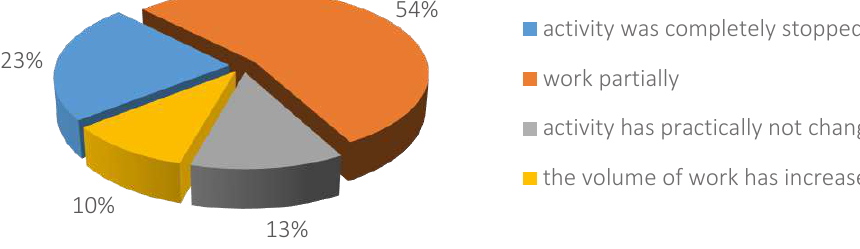
Figure 1. Mode of operation of the hospitality